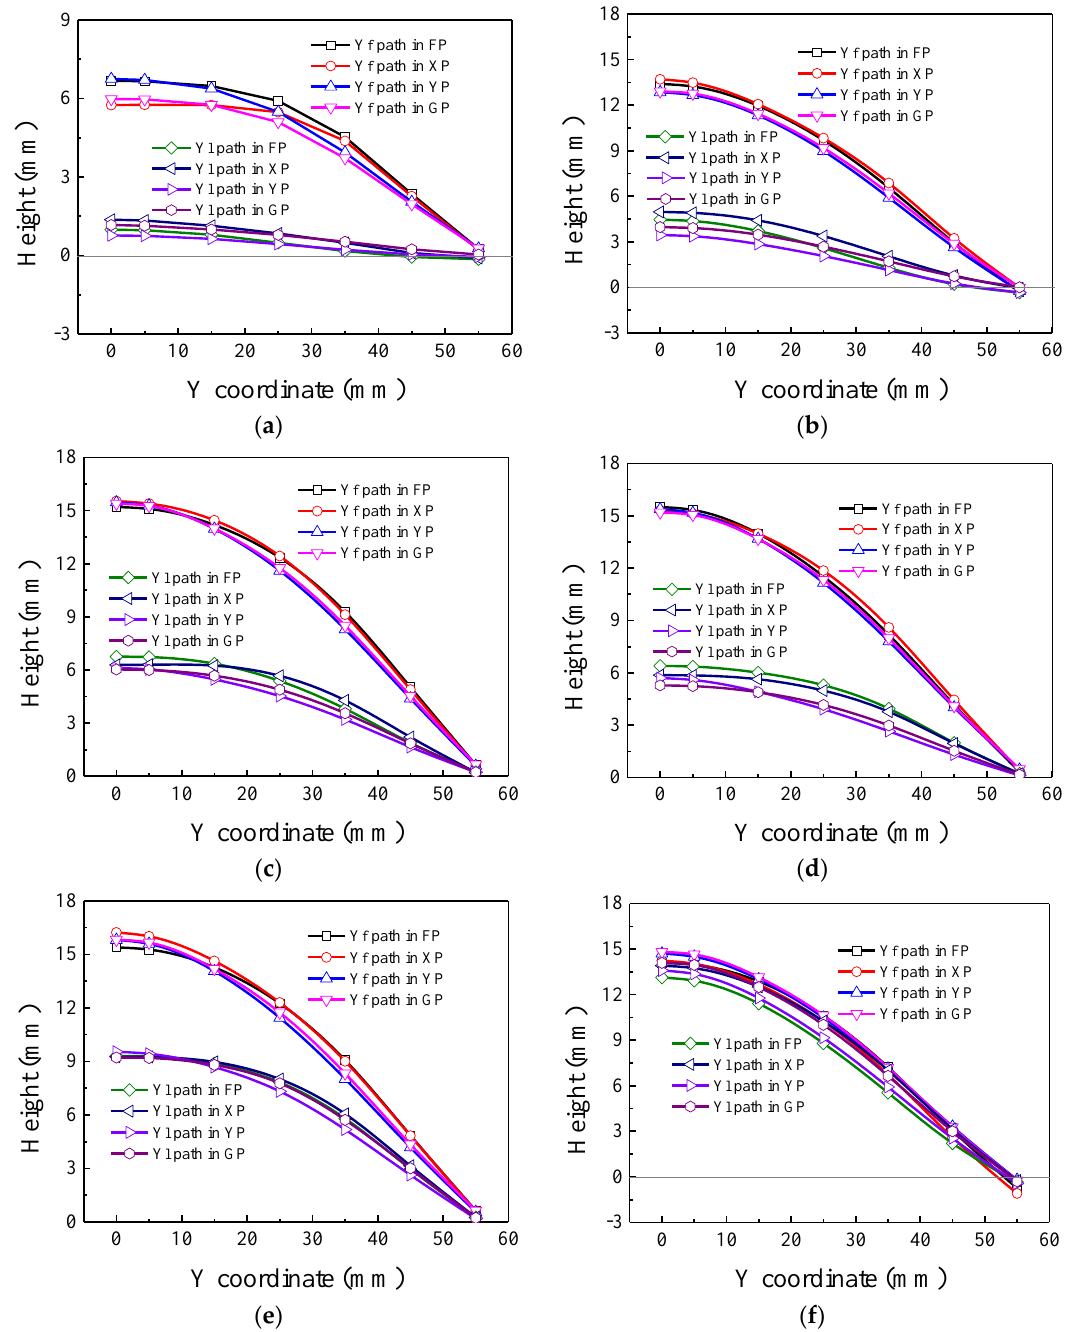
Figure 20. Z direction height distribution along Y direction paths of four panels during EMIF: ( a ) t = 0.15 ms; ( b ) t = 0.75 ms; ( c ) t = 0.90 ms; ( d ) t = 1.60 ms; ( e ) t = 1.75 ms; and ( f ) t = 2.45 ms. Y f and Y l represent Y former web-bottom path and Y latter web-bottom path, respectively.